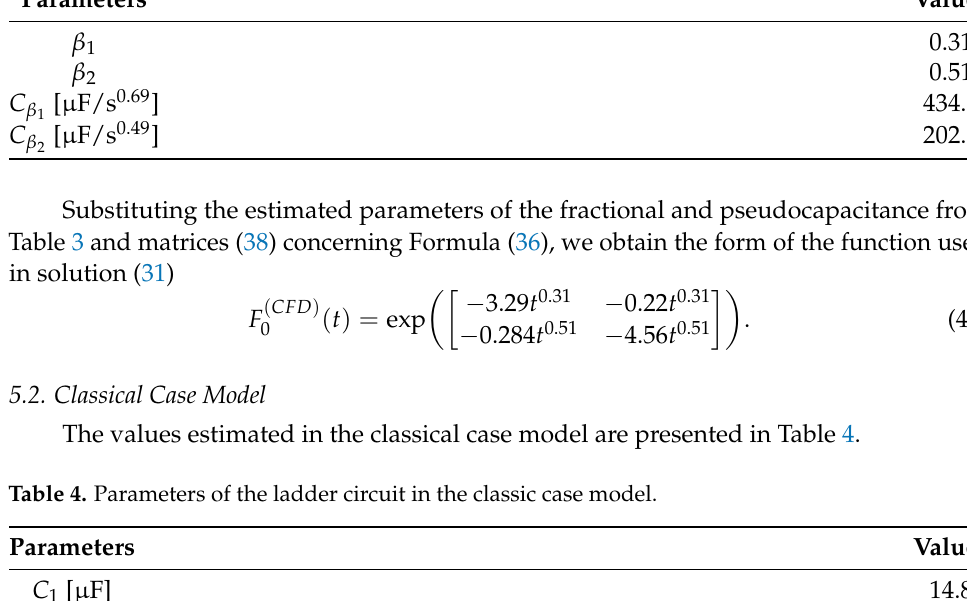
Table 3. Parameters of the ladder circuit in the Conformable Fractional Derivative (CFD) model. Parameters